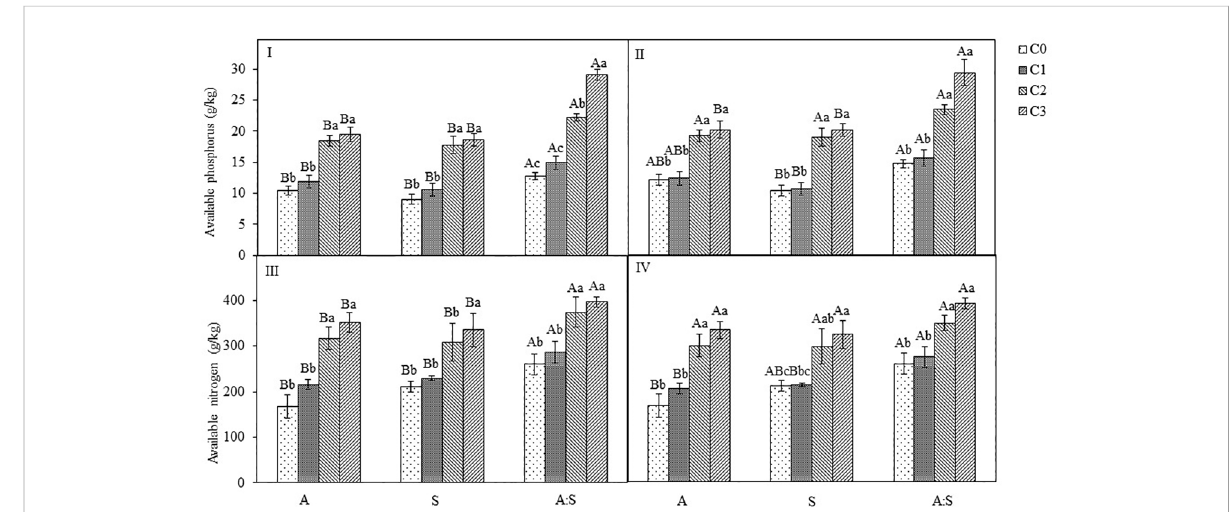
FIGURE 6 Effects of different concentration of B megaterium from the rhizosphere soil of A artemisiifolia (I and III) and S. viridis (II and IV) on soil available phosphorus and nitrogen levels. C0, control; C1: 5X10 8 cfu/mL of B. megaterium ; C2: 15X10 8 cfu/mL of B. megaterium ; C3: 30×10 8 cfu/mL of B. megaterium . Different uppercase letters indicate signi fi cant differences between in the mixture and in the monoculture treatments at P < 0.05. Different lowercase letters indicate signi fi cant differences among different concentrations of B megaterium at P <0.05. Error bars represent ±SD of mean( n